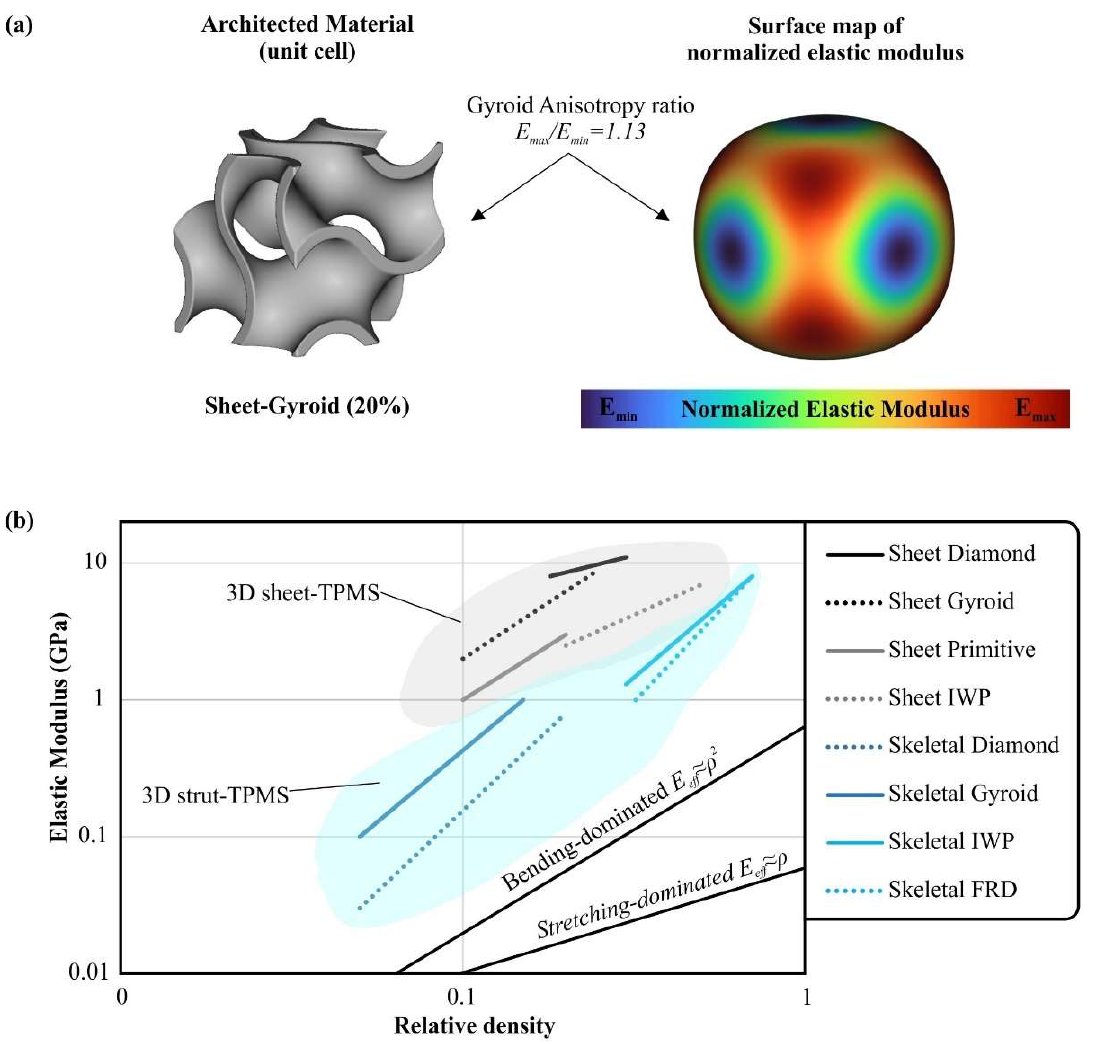
Figure 4. ( a ) Indicative surface map of the normalized local elastic modulus for a Gyroid structure coupled with a value of the E max / E min ratio, ( b ) Effective elastic modulus and the mechanical behav-